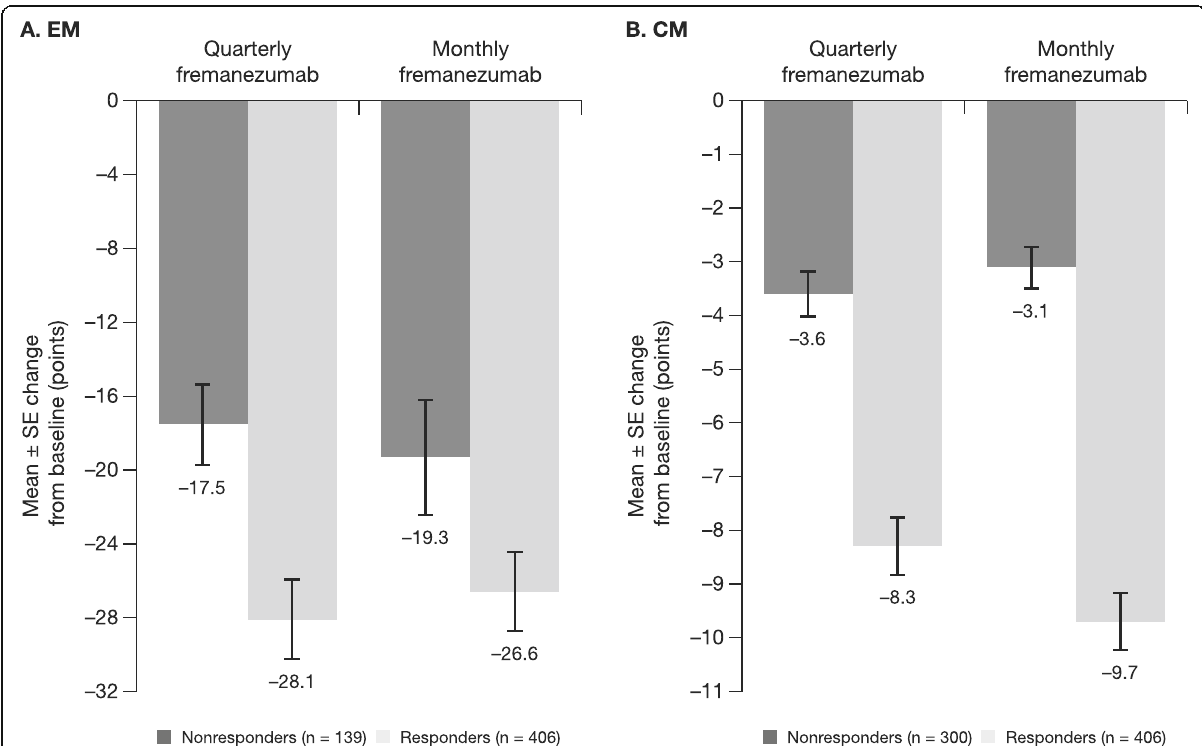
Fig. 5 Mean change from baseline in headache-related disability, as measured by ( a ) MIDAS a and ( b ) HIT-6 b . CM, chronic migraine; EM, episodic migraine; HIT-6, 6-item Headache Impact Test; MAMD, monthly average migraine days; MIDAS, Migraine Disability Assessment; SE, standard error. a For participants with EM, response was defined as a reduction of ≥ 2 MAMD. b For participants with CM, response was defined as a reduction